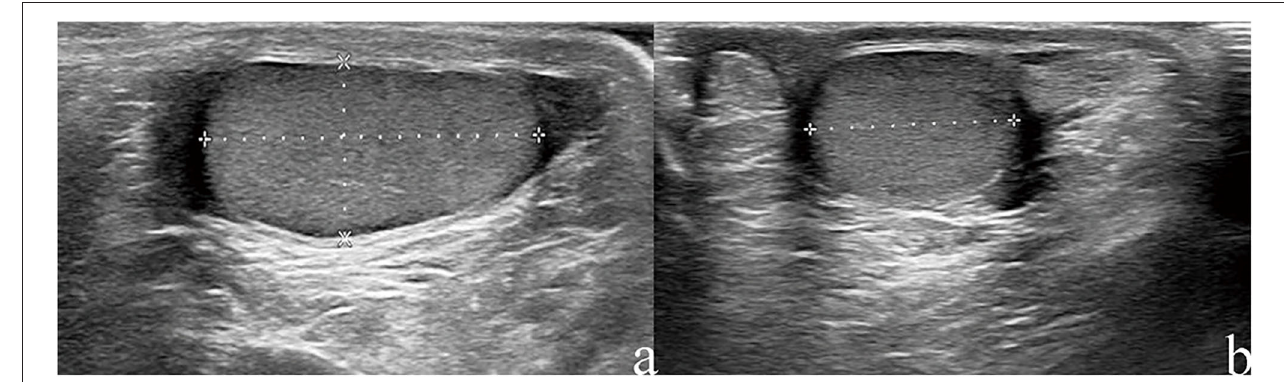
FIGURE 1 | Measurement of testicle length, width, and height by Ultrasound on a 7-years old boy. The dotted lines show measurement of length and height in the longitudinal plane (a) and width in the transverse plain (b) .